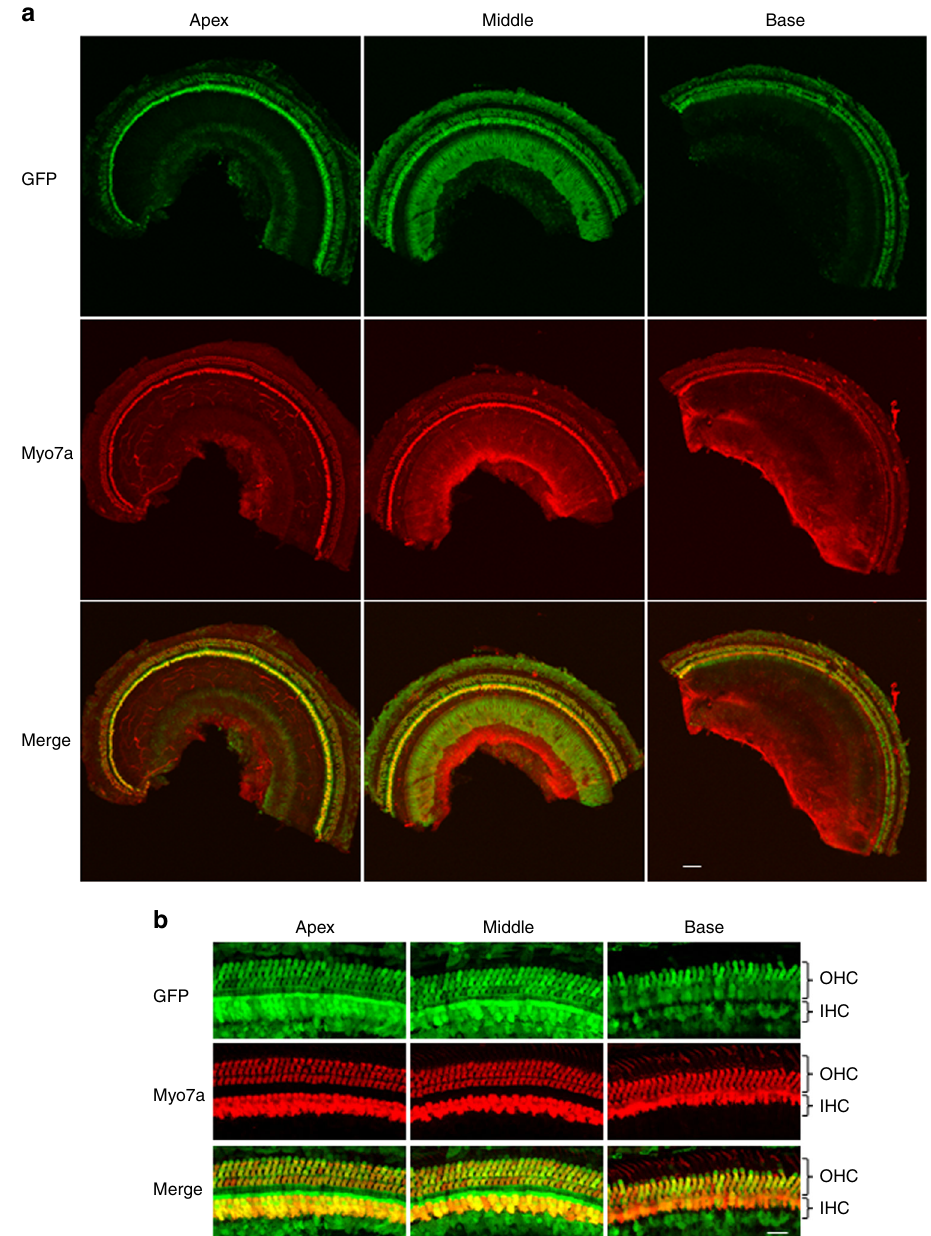
Fig. 2 AAV2.7m8 infects inner and outer hair cells throughout the entire cochlea.10 × ( a ) and 40 × ( b ) images of a mouse cochlea that underwent AAV2.7m8-GFP injection via the posterior semicircular canal approach. GFP expression is seen in both IHCs and OHCs throughout the entire cochlea. GFP expression is shown in green, and Myo7a expression (a marker for hair cells) is shown in red. Scale bar represents 50 μ m for 10 × and 20 μ m for 40 ×